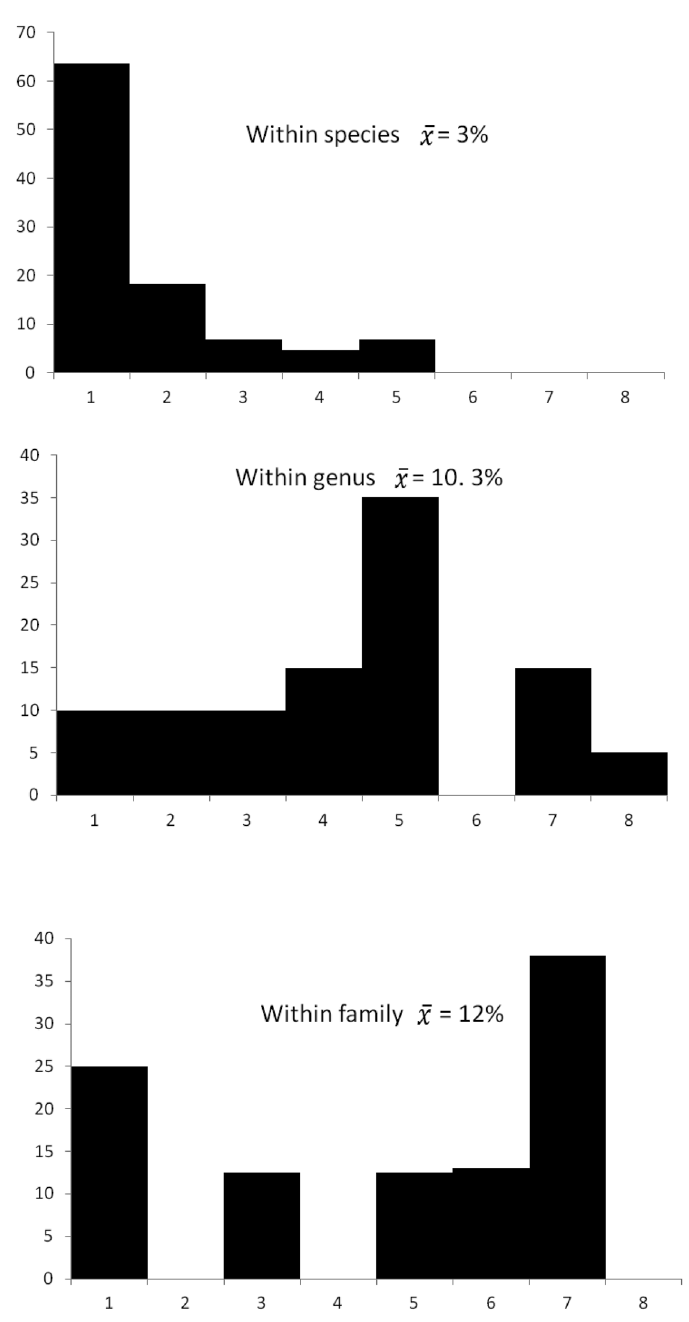
Figure 3. COI sequence divergence (K2P) at various levels of the taxonomic hierarchy for